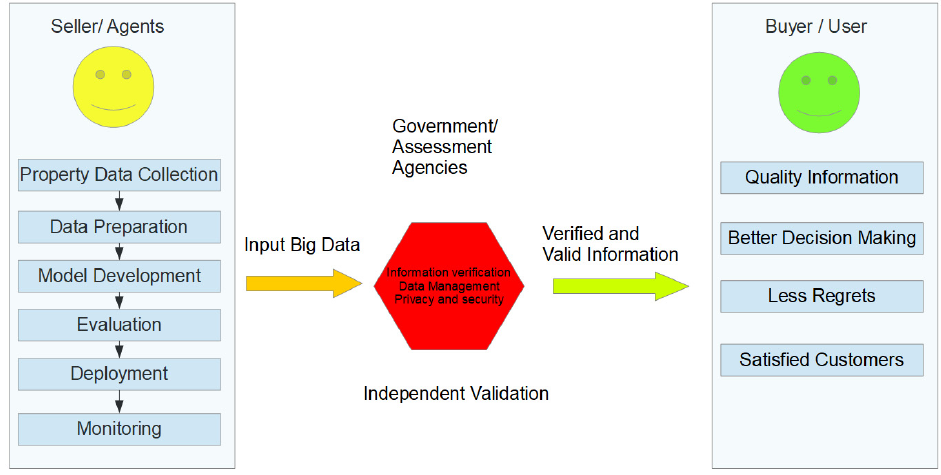
Figure 12. Conceptual model for big data utilization in real estate transactions with decentralized validation to ensure data integrity.